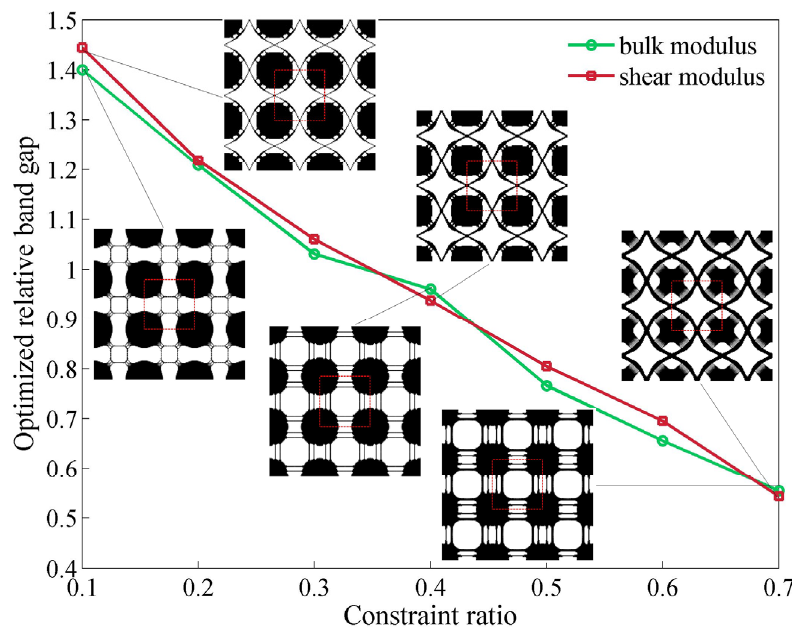
Figure 4. Optimized relative band gap against different constraint ratio with bulk and shear modulus constraints.